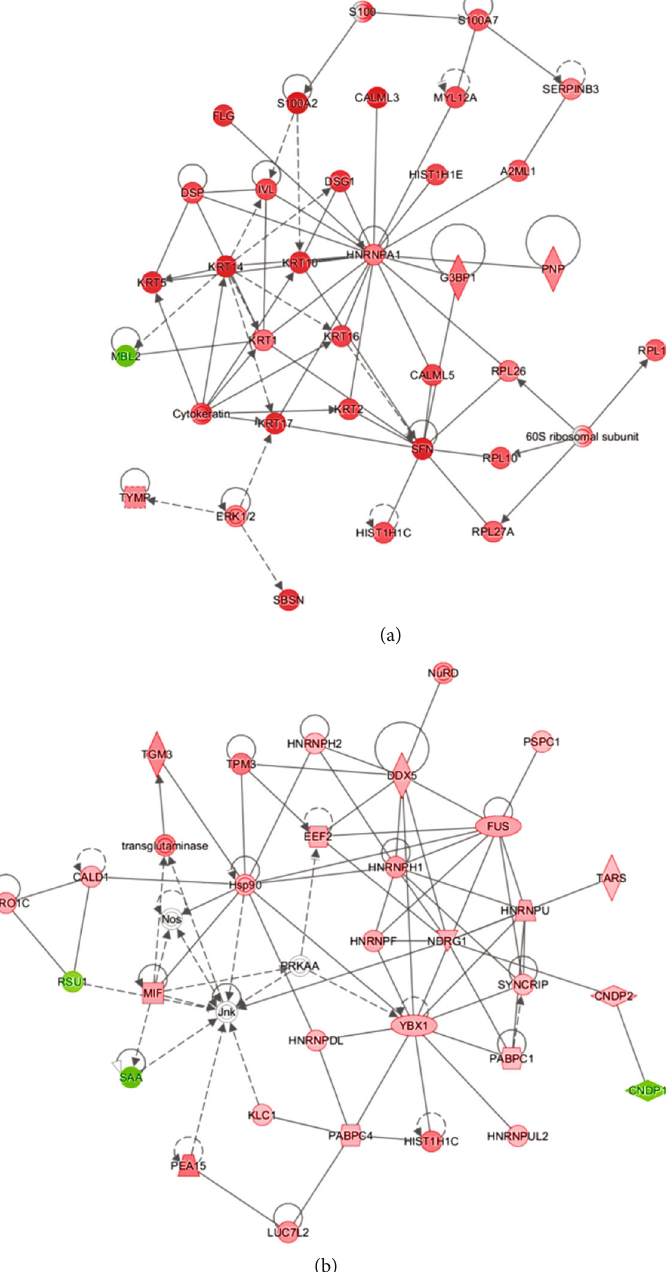
Figure 8: Interaction network of di ff erential proteins. (a) The fi rst interaction network in C/B group. (b) The third interaction network in D/ B